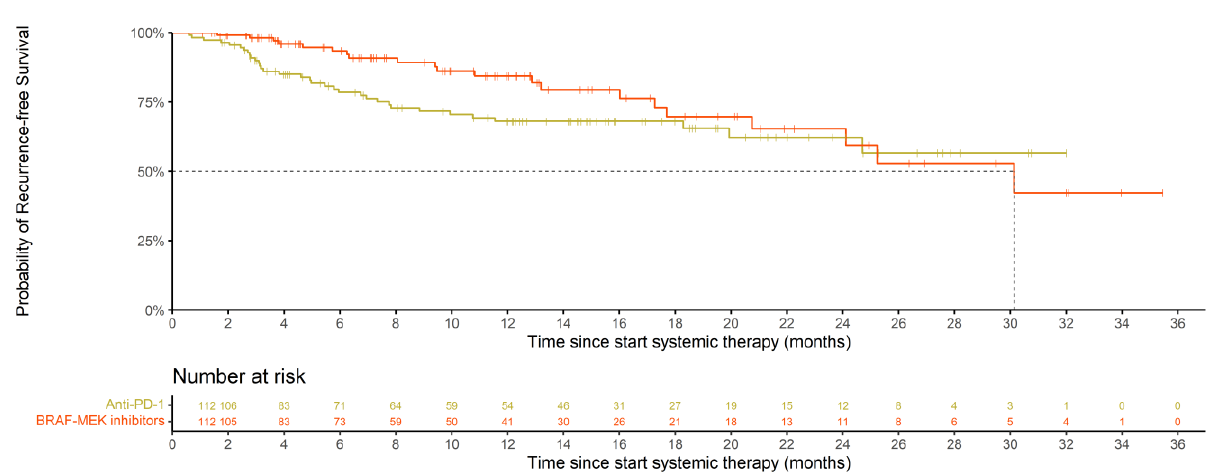
Figure 3. Recurrence-free survival (RFS) of BRAF/MEK- and anti-PD-1-treated patients after nearest neighbor propensity score matching.